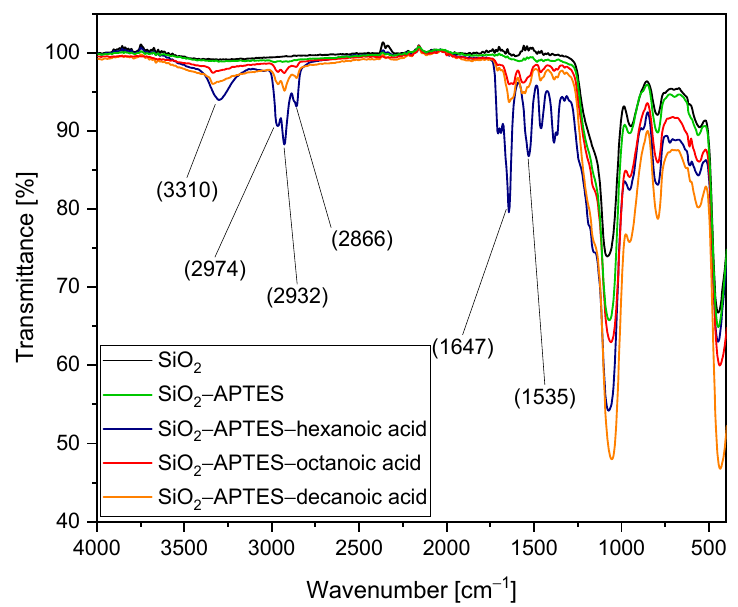
Figure 4. FTIR spectra of 45 nm silica nanoparticles: unmodified silica particles used as a reference (SiO 2 ); SiO 2 modified with APTES (SiO 2 –APTES); and SiO 2 modified with APTES with hexanoic (SiO 2 –APTES–hexanoic acid), octanoic (SiO 2 –APTES–octanoic acid), and decanoic acid (SiO 2 –APTES–decanoic acid).